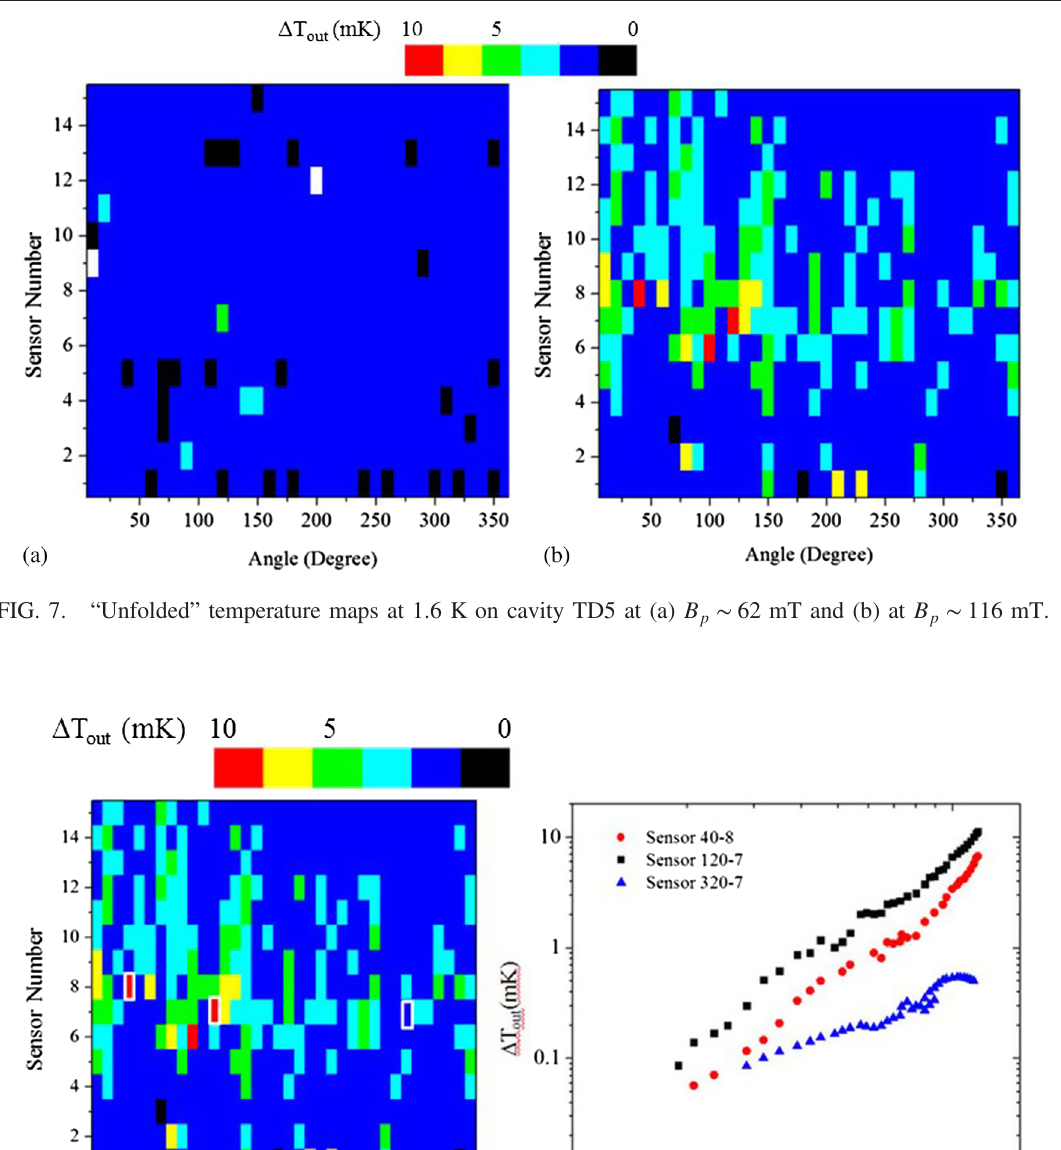
FIG. 8. “ Unfolded ” temperature map at 2.0 K on cavity TD5 (a) just before quench ( B p ∼ 116 mT) and (b) Δ T different locations highlighted with a white border in (a), during increasing rf